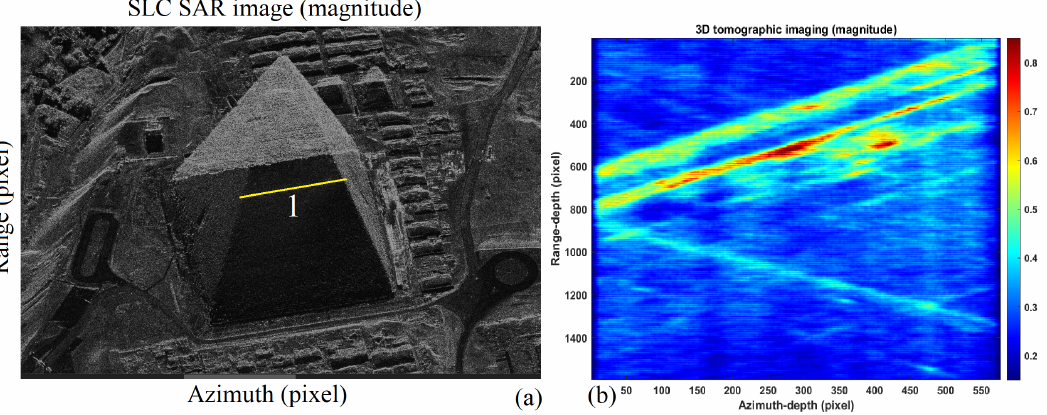
Figure 31. SAR images. ( a ): SLC SAR image (magnitude). The tomographic line 1 is oriented along the Western-side of the pyramid. ( b ): Tomographic result